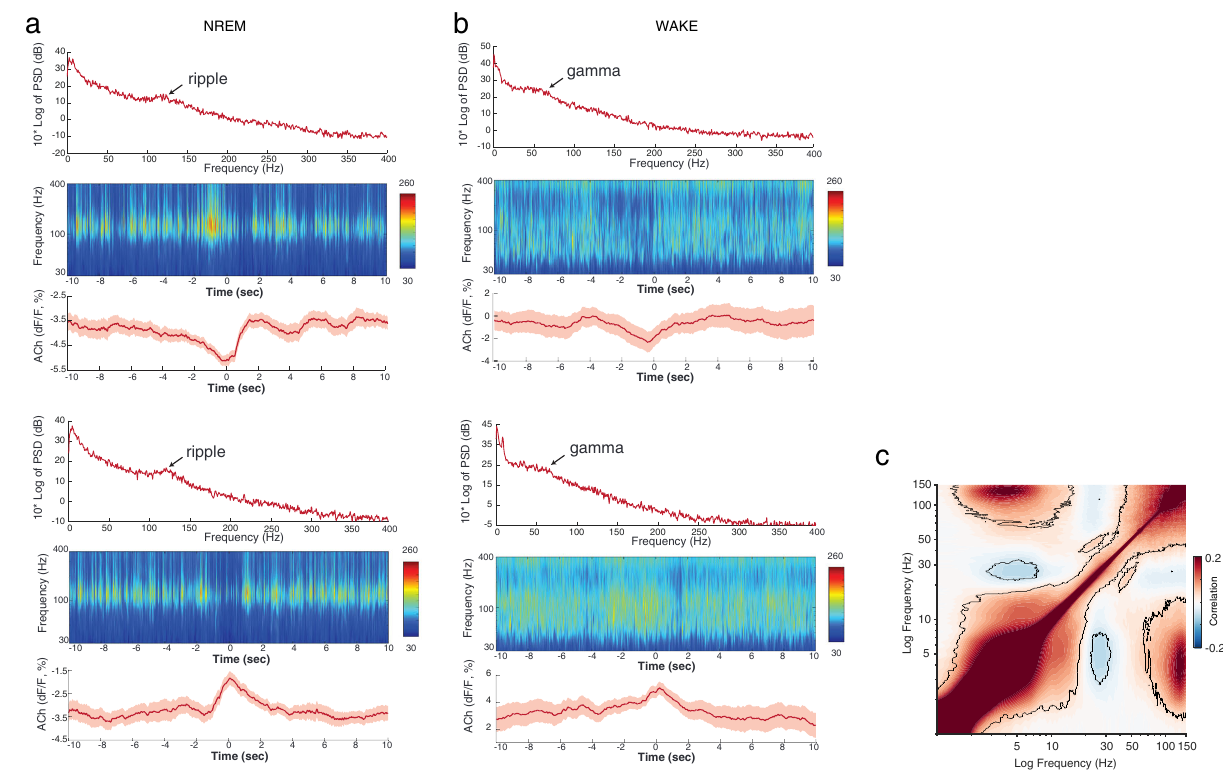
Fig. 6 | Relationship between Ach levels in the hippocampus and SPW-R/ gamma power. a Power spectrum (0 – 400Hz) and time-resolved power spectrum (40 – 400Hz) of the LFP recorded from the CA1 pyramidal layer of a mouse, cen- tered at the natural fl uctuations of Ach levels (troughs and peaks, respectively). b Sameasin b butduringwaking.Notetheabsenceofripples(>100Hz)duringAch peaks, whereas highest gamma power (40 – 120Hz) is present at the highest levels